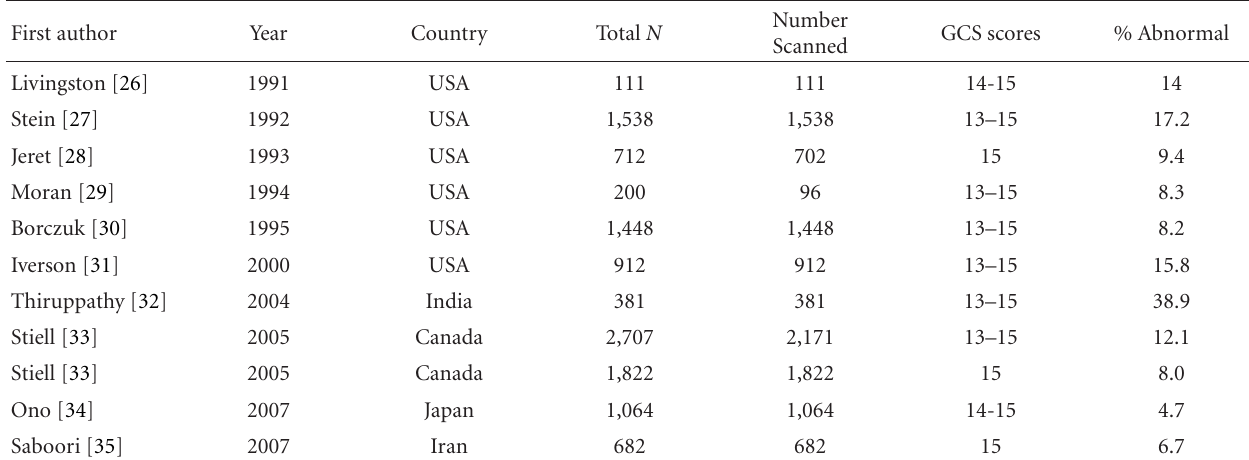
Table 1: Rates of complicated mild TBI in